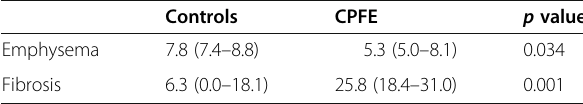
Table 2 Comparison of signal intensity between emphysema and fibrosis in CPFE patients and equivalently located regions